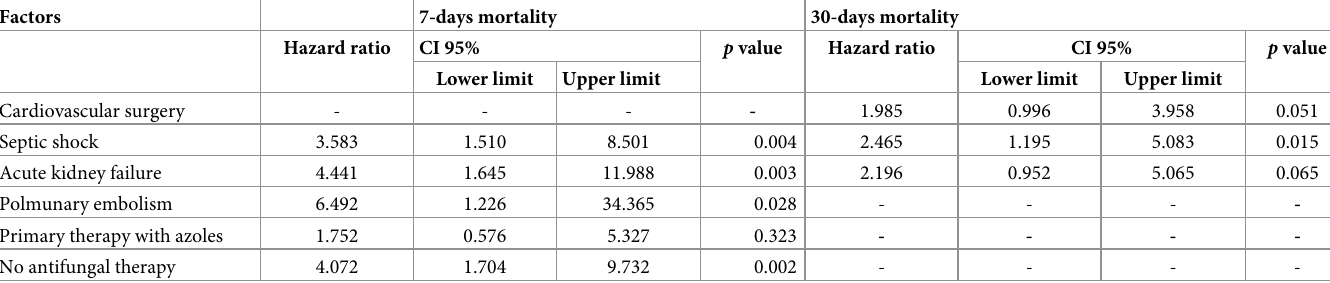
Table 4. Risk factors associated with 7- and 30-day mortality in ICU patients with candidemia analyzed by logistic regression.